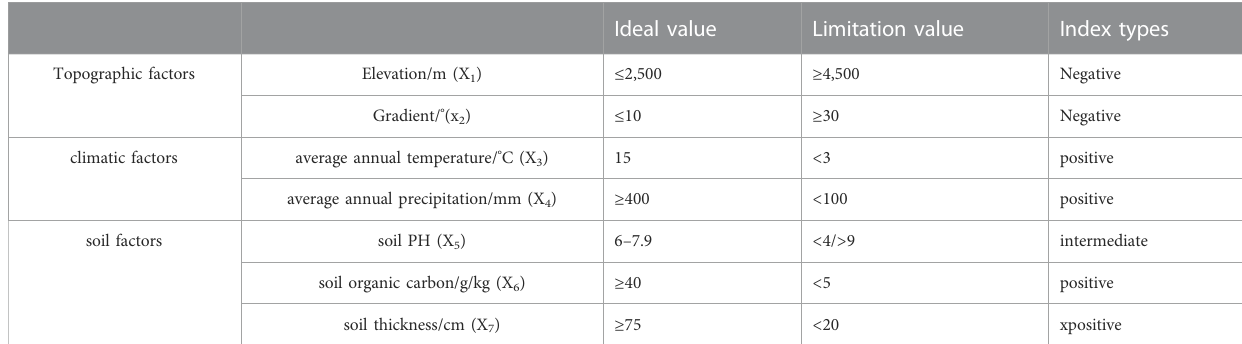
TABLE 1 Natural quality classi fi cation of cultivated land.